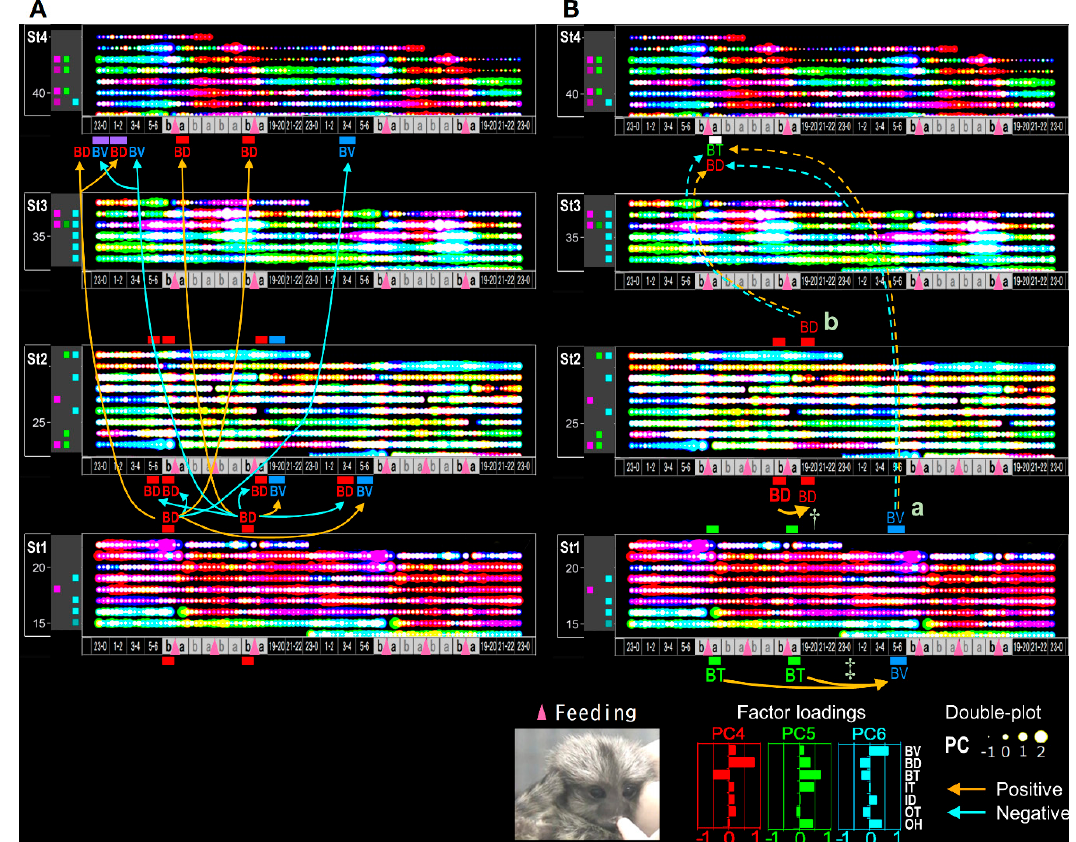
Figure 13. The origin of candidate trigger pathways revealed in Figure 10. The double plots are same as shown in Figure 10B, overlay of PC4–PC6. ( A ) The pathways from the maximum explanatory nodes revealed in the regression of arbitrary B-indices on BD. ( B ) Solid lines marked by a dagger and double dagger indicate the original pathways of key pathways marked by “a” and “b” corresponding to “a” and “b” in Figure 10(B5,B6).